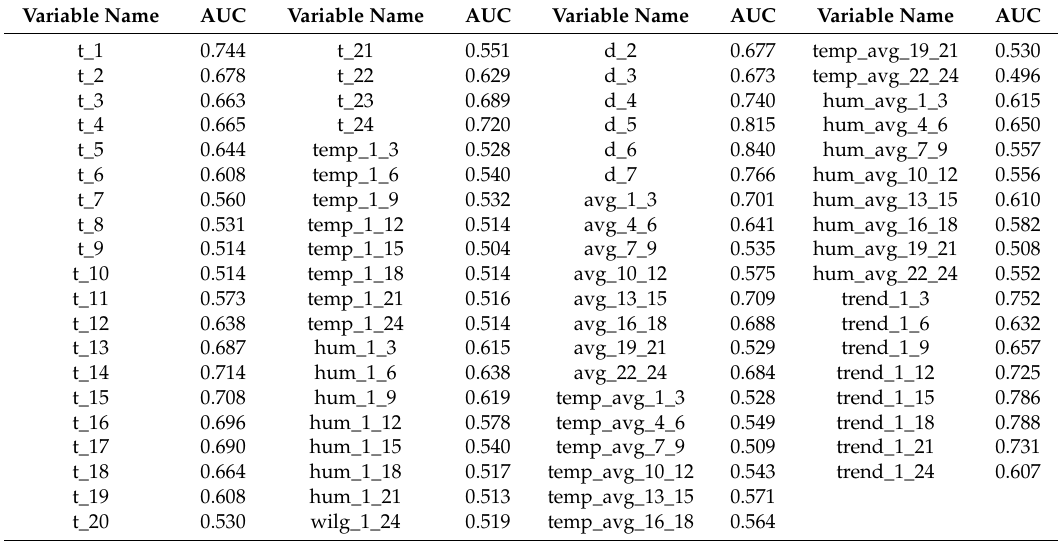
Table 2. Area under the curve (AUC) values for the quantitative variables used to detect 99th percentile peaks.